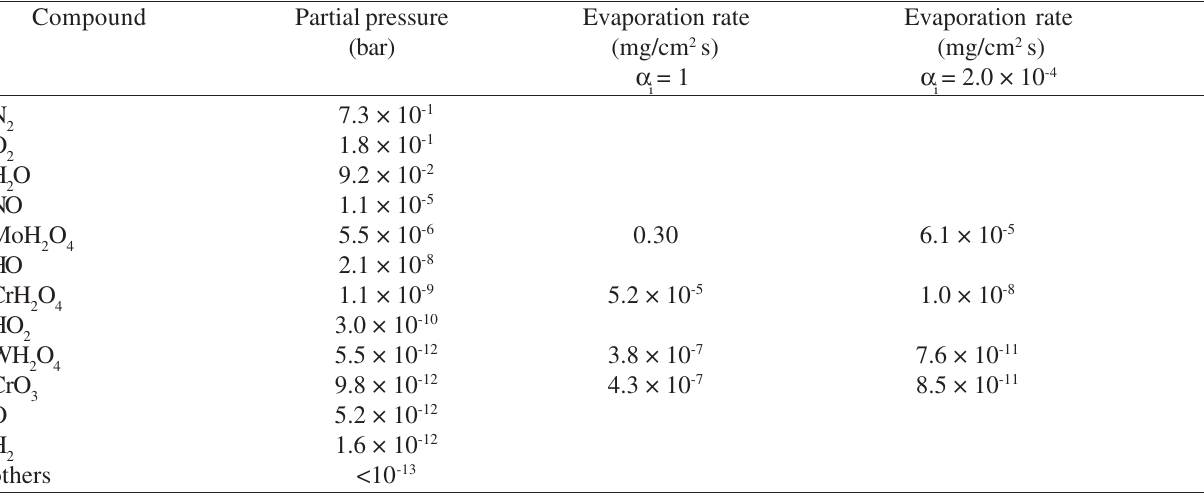
O at 650 °C in the presence of Cr, Cr 2